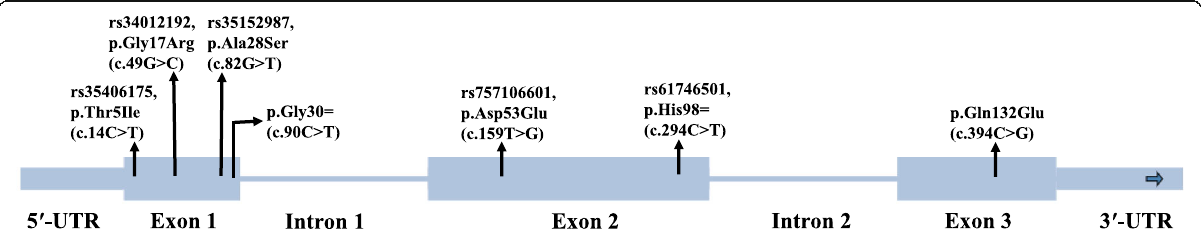
Fig. 1 Location of synonymous SNVs and nonsynonymous SNVs observed in the HBD gene in the Iranian population, based on the Iranome project (http://www.iranome.ir/)